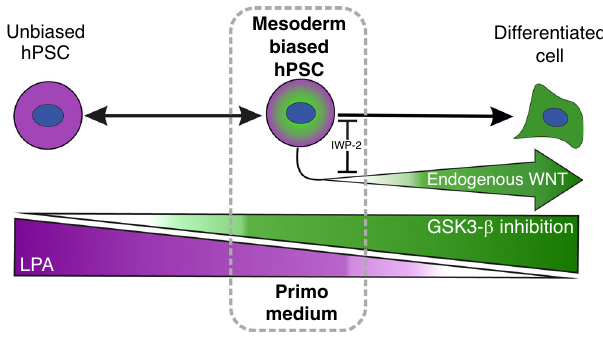
Fig. 8 A schematic diagram of the trapping of a Mesoderm Biased Human PSC (hPSC). The cross antagonism of the pro-pluripotency factor (LPA) and pro-differentiation factor (GSK3 β Inhibition) is able to induce a mesoderm biased state in human PSC but endogenous WNT secreted by the cells drives further differentiation. Using IWP-2 to block this endogenous WNT secretion prevents this further differentiation. These three components of PRIMO medium permit the maintenance of the mesoderm biased state in